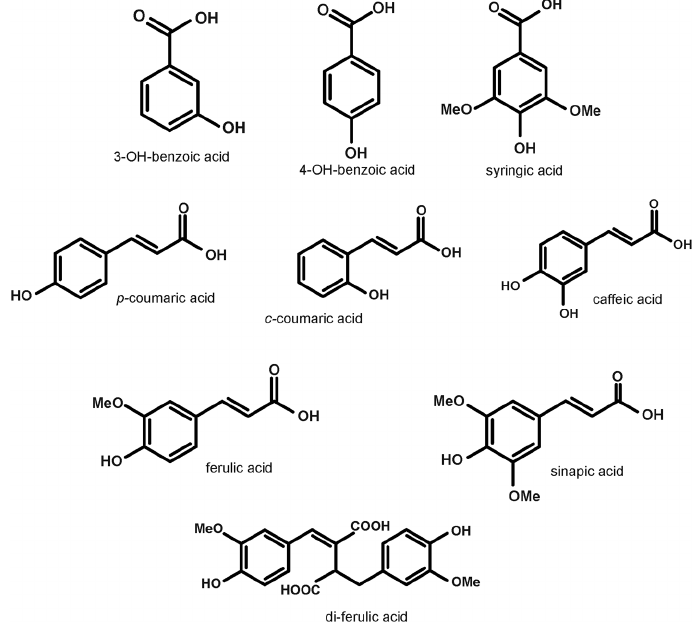
Molecules 2021 , 26 , 562 Figure 1. The chemical structure of identified phenolic acid in triticale. Figure 1. The chemical structure of identified phenolic acid in triticale.